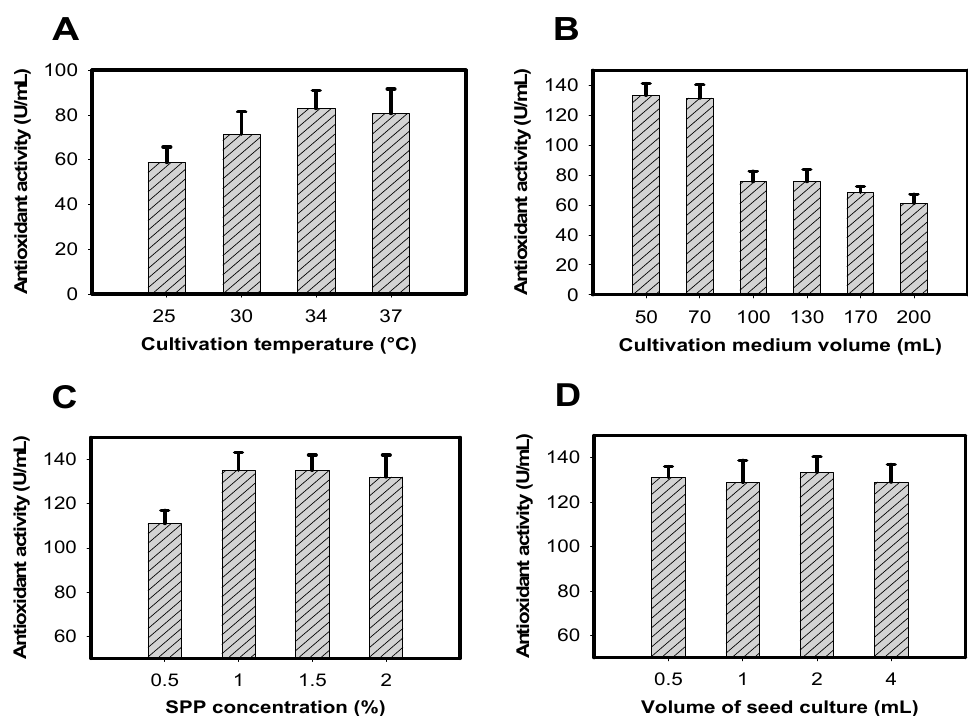
Figure 3. Effects of ( A ) culture temperature, ( B ) culture medium volume, ( C ) SPP concentration, and ( D ) bacterial seed volume on antioxidant production.